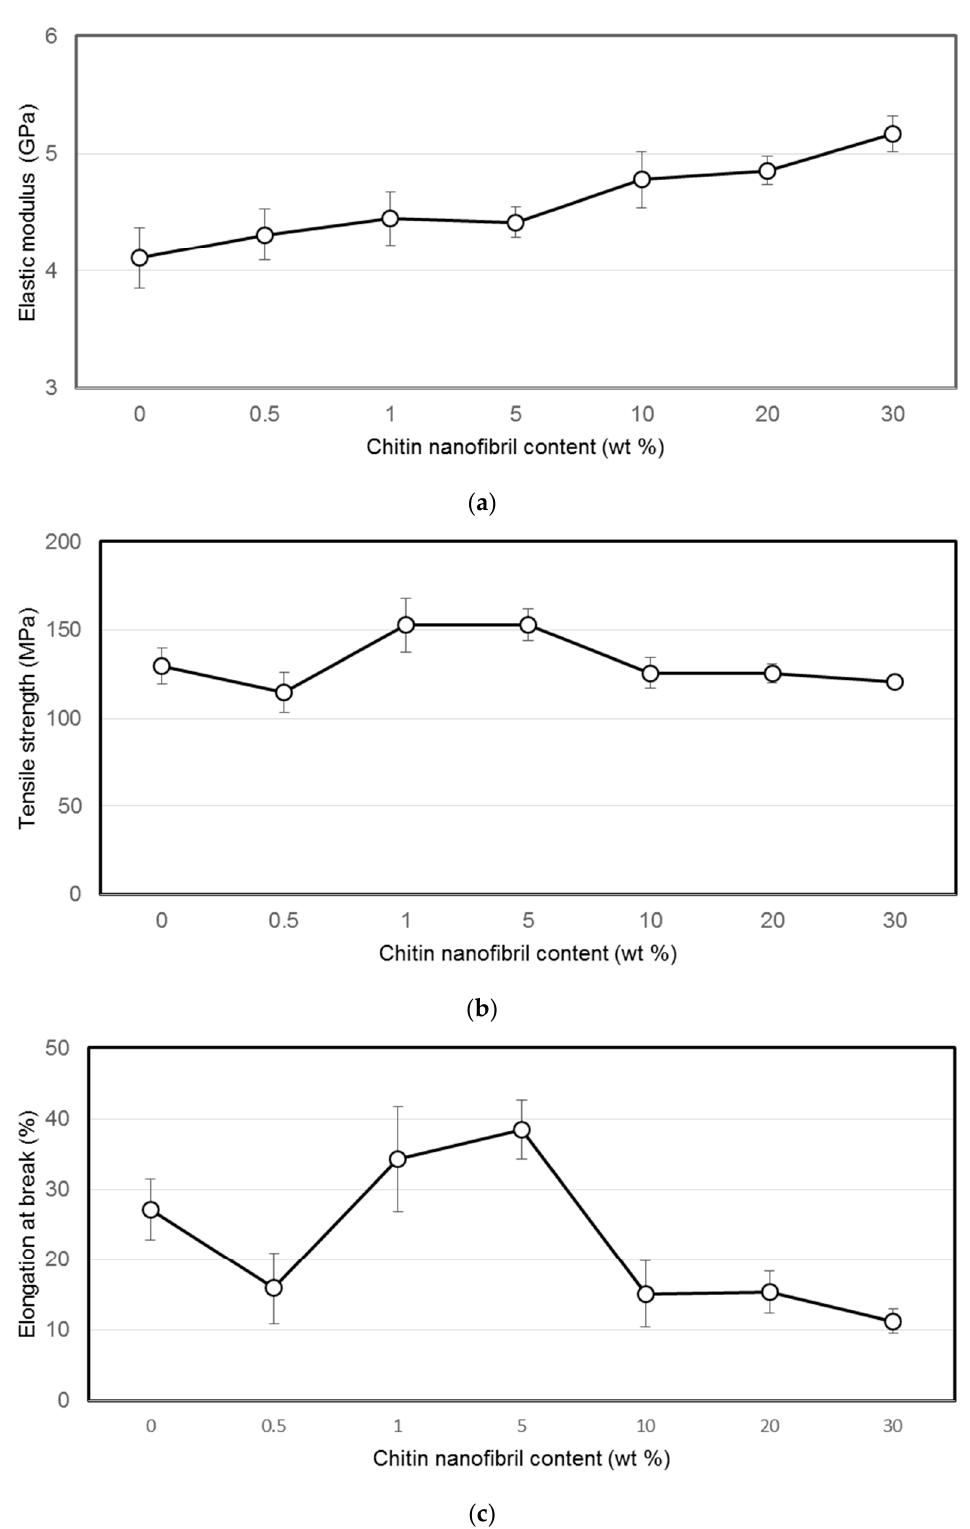
Figure 1 . ( a ) Elastic modulus, ( b ) tensile strength, and ( c ) elongation at break of pure chitosan and chitin nanofibril-reinforced chitosan films as a function of chitin nanofibril content.